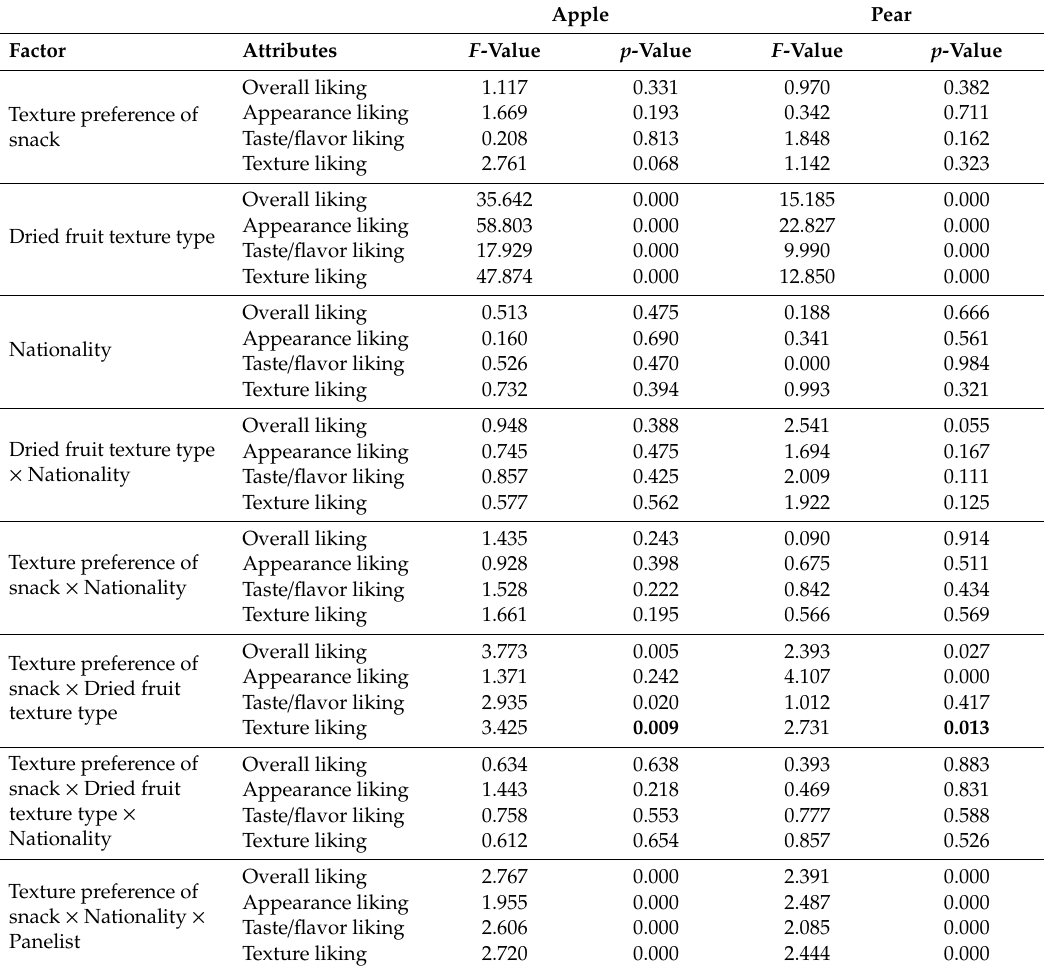
Table 6. F - and p -values associated with statistical significance for seven types of dried apple and pear